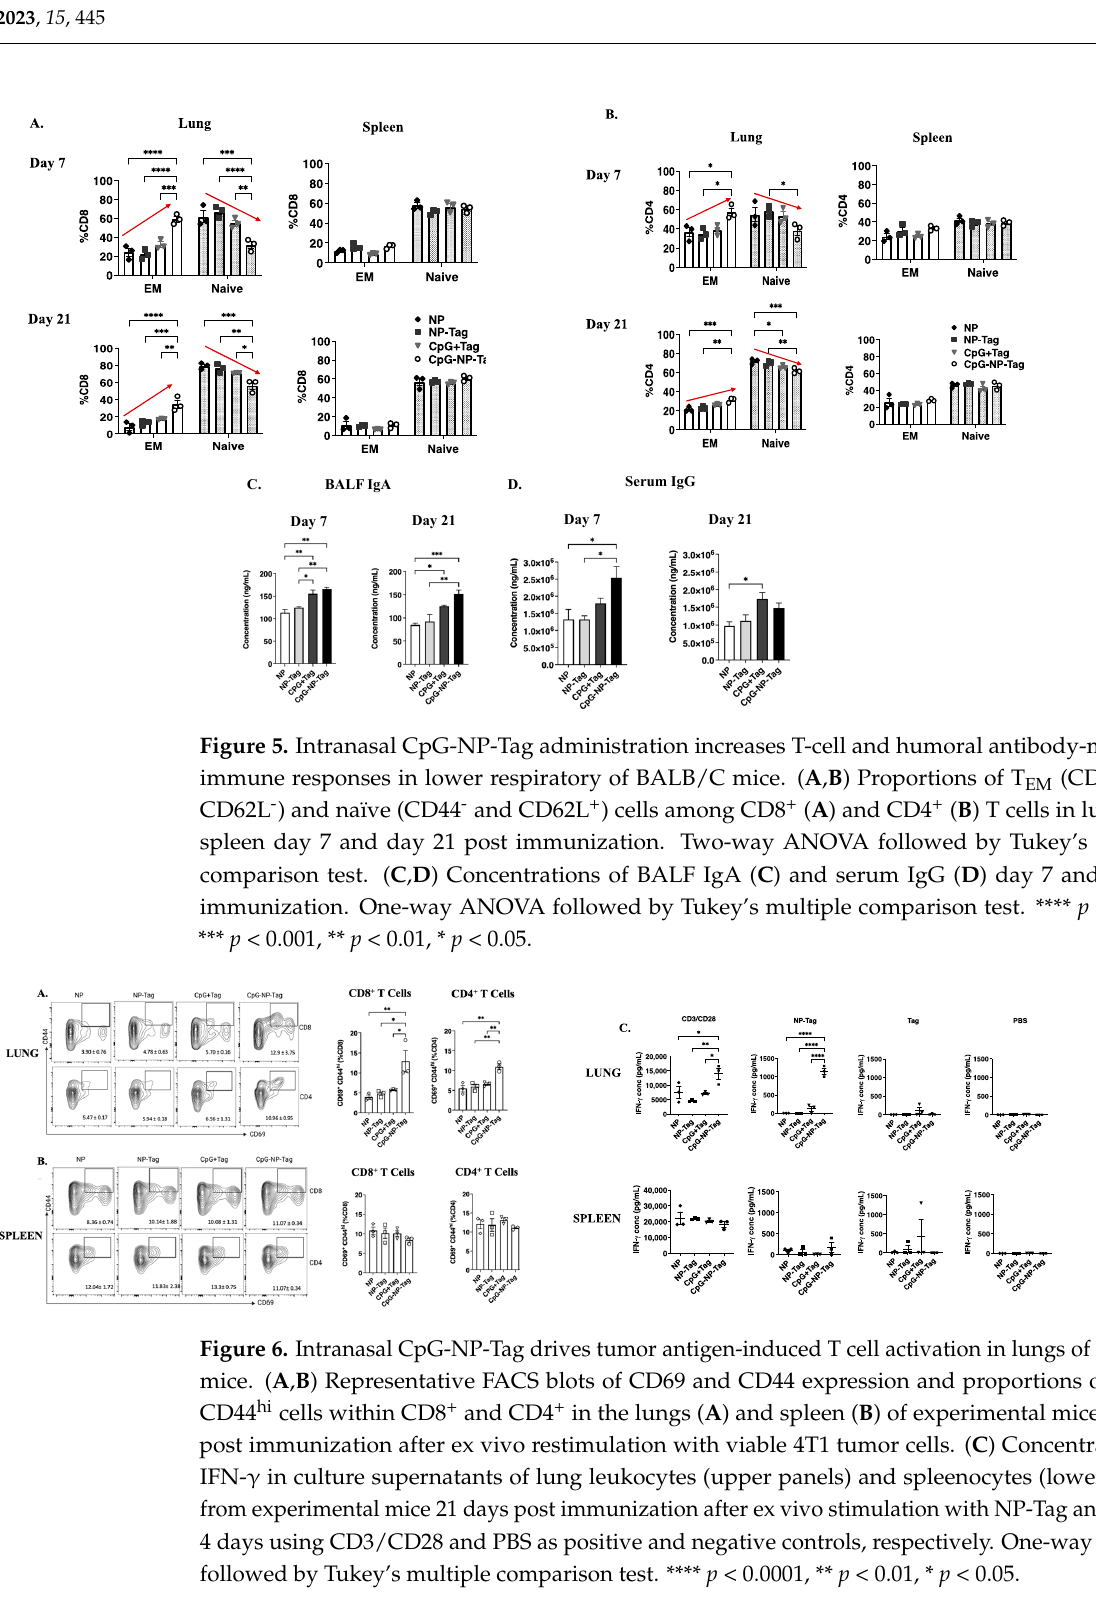
Figure 5. Intranasal CpG-NP-Tag administration increases T-cell and humoral antibody-mediated immune responses in lower respiratory of BALB/C mice. ( A , B ) Proportions of T EM (CD44 + and CD62L - ) and naïve (CD44 - and CD62L + ) cells among CD8 + ( A ) and CD4 + ( B ) T cells in lungs and spleen day 7 and day 21 post immunization. Two-way ANOVA followed by Tukey’s multiple com- parison test. ( C , D ) Concentrations of BALF IgA ( C ) and serum IgG ( D ) day 7 and 21 post immun- ization. One-way ANOVA followed by Tukey’s multiple comparison test. **** p < 0.0001, *** p < 0.001, ** p < 0.01, * p < 0.05.